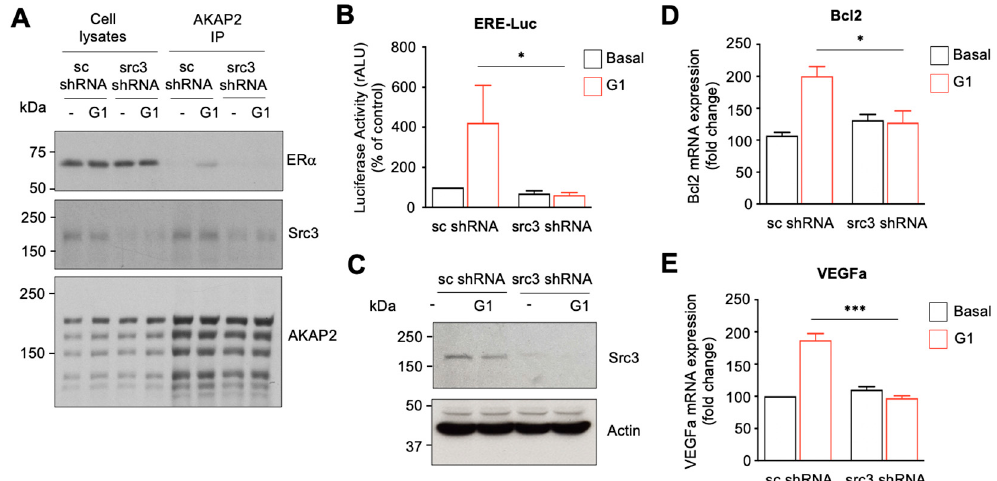
Figure 7. GPR30-induced ER activation in cardiomyocytes requires Src3. ( A ) Rat NVMs were infected by using lentiviruses encoding Src3 shRNAs or scrambled shRNAs (sc shRNA). Seventy-two hours after infection, cells were serum starved for 24 h and subsequently incubated with or without 10 − 7 M G1 for 15 min. Rat NVMs were then lysed and extracts subjected to immunoprecipitation with affinity purified anti-AKAP-2 antibodies. Western blots of the immunoprecipitates and the cell extracts were revealed by using either anti-ER α (upper panel), anti-Src3 (middle panel) or anti-AKAP-2 monoclonal antibodies (lower panel). ( B ) Rat NVMs were infected by using lentiviruses encoding Src3 or scrambled (sc) shRNAs and subsequently transfected with ERE-firefly luciferase and renilla luciferase reporter constructs. Seventy-two hours after infection, cells were incubated for 8 h in the absence or presence of 10 − 7 M G1. Firefly-luciferase activity was normalized to Renilla-luciferase activity. Results are the mean ± SE of 6 independent experiments; * p < 0,05. ( C ) Expression of src3 and actin in the lysates was assessed as indicated by immunoblot, using specific antibodies. ( D , E ) Rat NVMs were infected as indicated in ( A ). Seventy-two hours after infection, cells were serum starved for 24 h and subsequently treated with 10 − 7 M G1 for 24 h. Bcl2 and VEGFa mRNA expression was determined by quantitative PCR. Results are the mean ± SE of 3 independent experiments; * p < 0,05; *** p < 0,001.